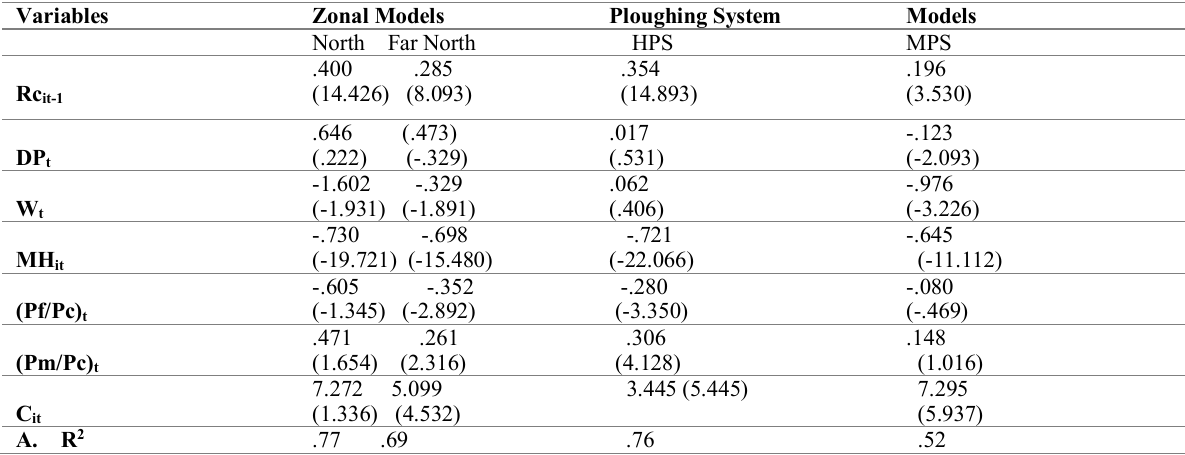
Table 6: Regression Results for the sub-sample Models (T-statistics in